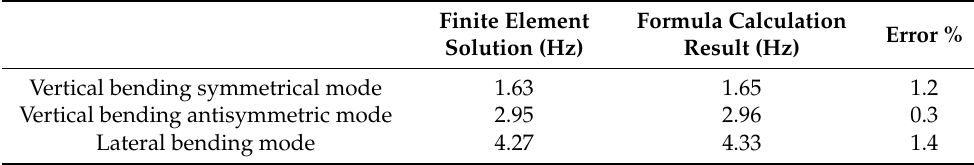
Table 1. Fundamental frequency calculated by the proposed method.